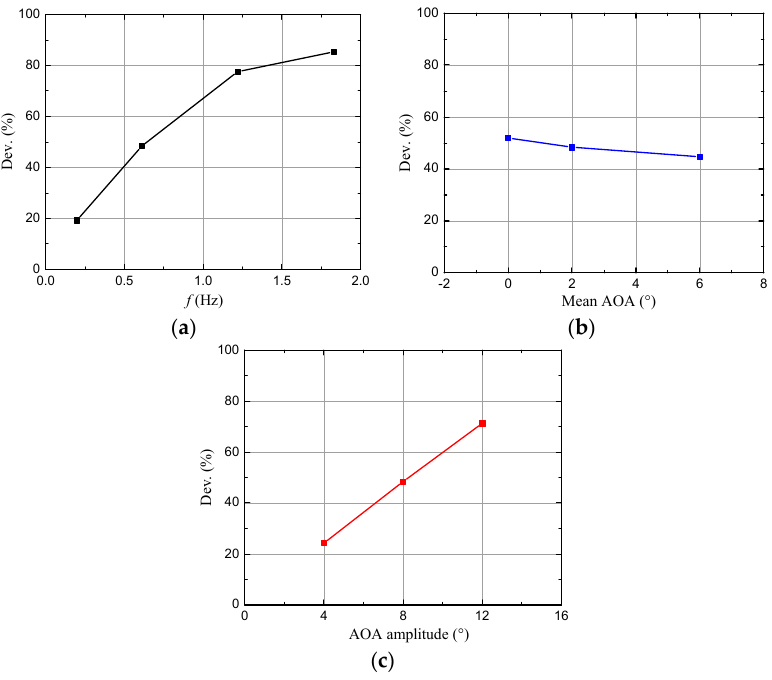
Figure 14. Effects of the oscillation frequency, the mean AOA and the AOA amplitude on the deviation between pitch oscillation and oscillating freestream. ( a ) Effect of the oscillation frequency;